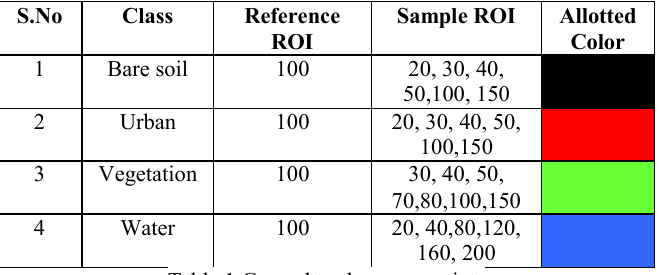
Fig. 4 Supervised support vector machine Spectral information divergence: In this method divergence measures are used to match pixel with the reference spectrum.